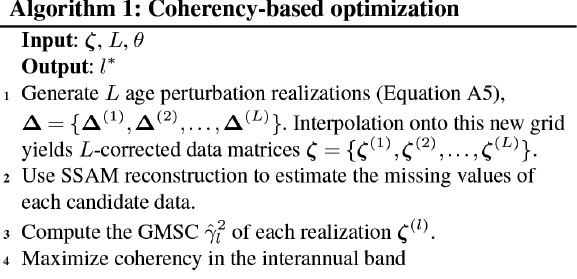
Table 4. Time-uncertain ensemble 95% CI width means µ and stan- dard deviations σ , and probabilities of the ensemble CI covering the original data with respect to θ